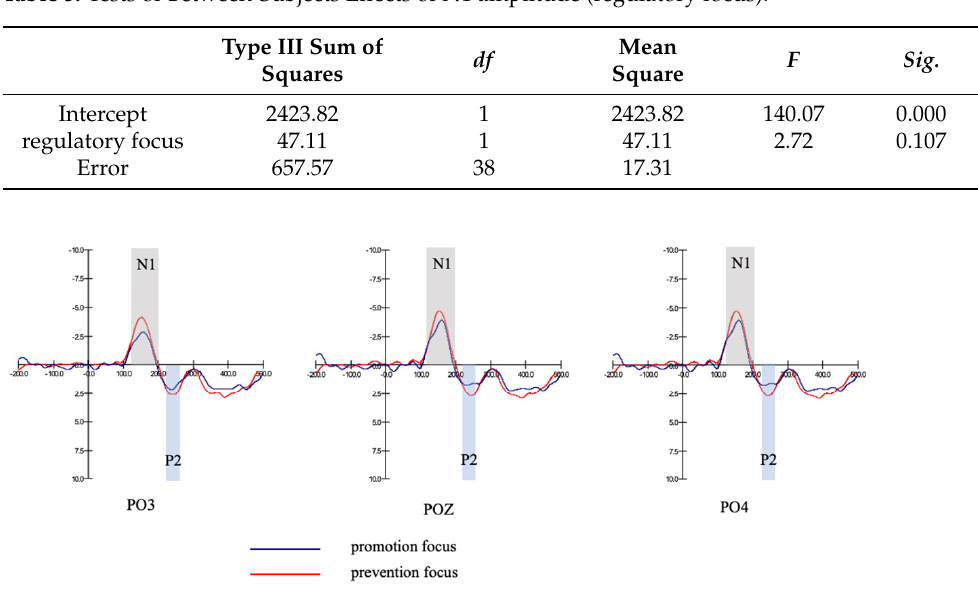
Table 6. Multivariate tests of N1 amplitude (promotion focus).